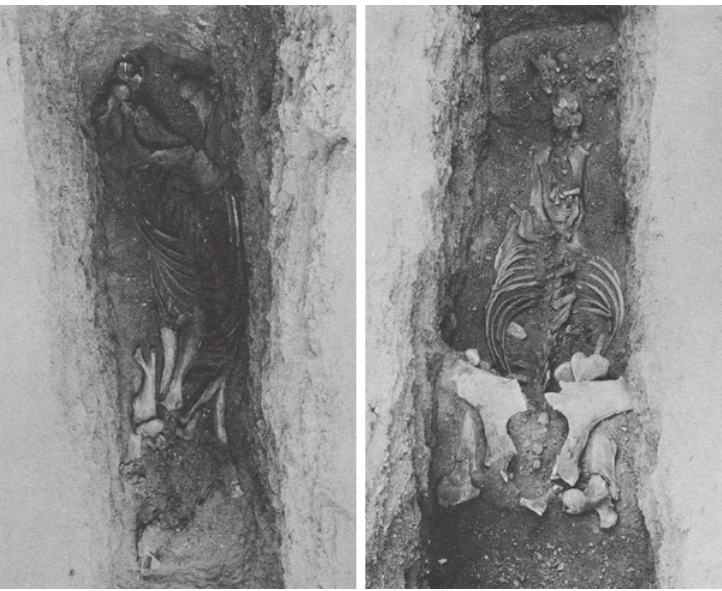
Figure 3 Grave pits Ku. 209 (left) and Ku. 210 (right) with horse skeletons in situ . (Image credit: Dunham 1950, pls XXVIII.B,